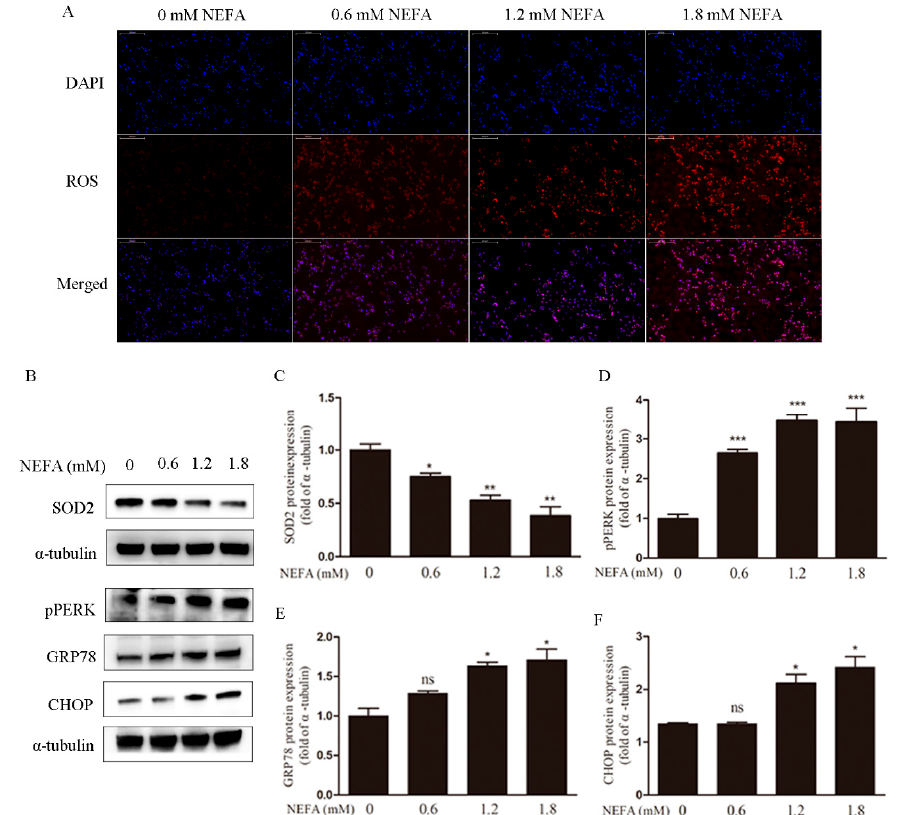
Figure 1. Non-esterified fatty acid (NEFA) causes accumulation of reactive oxygen species (ROS) and endoplasmic reticulum stress in granulosa cells (GCs). ( A ) The accumulation of ROS in different concentrations of NEFA for 24 h was observed by immunofluorescence (scale bar, 200 µ m). It indicates that the accumulation of ROS increases with the increase of NEFA concentration. ( B , C )